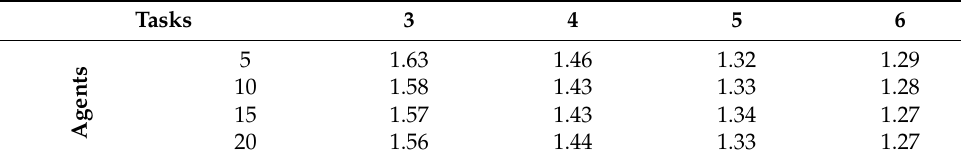
Table 4. Mean Improvement in Acceptable TBRM States per MAS (Scenario 1).